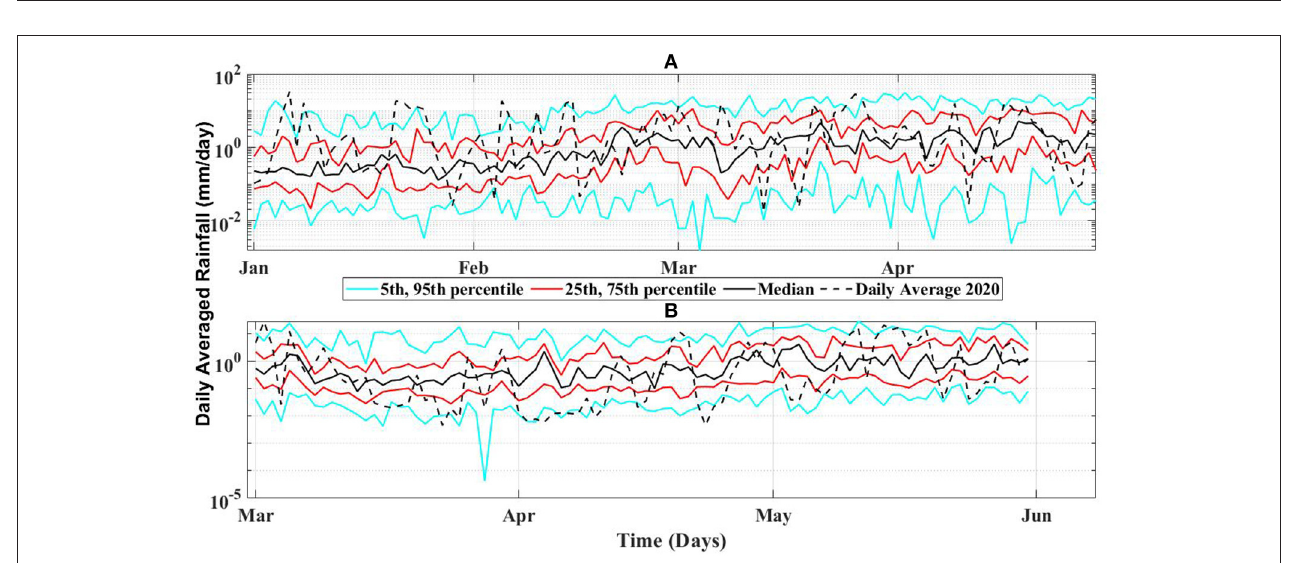
FIGURE 4 | Time series of daily averaged IMERG precipitation in mm/day across the (A) Hubei Province, China and (B) Northern Italy, showing the 5th, 25th, 50th (median), 75th, and 95th percentiles of the precipitation distribution observed during the springs of 2001–2019 and average values during spring 2020 (dashed black